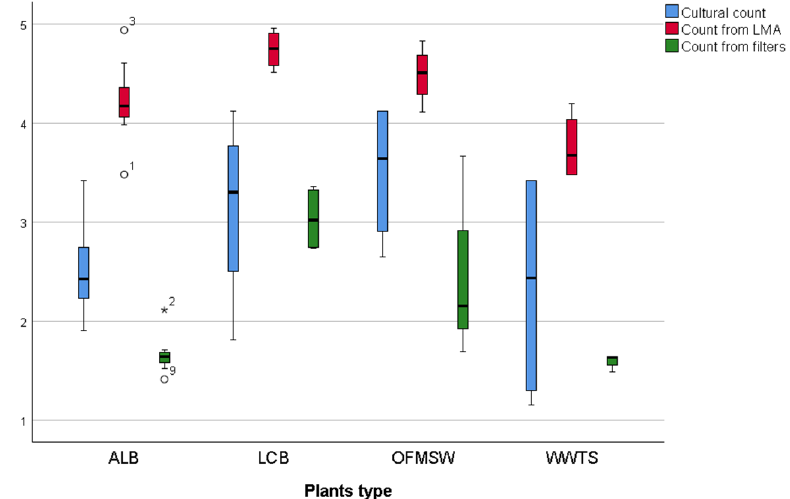
Figure 1. Boxplot of bacterial quantification methods for each plant type. Legend: cultural count represents the total mesophilic cultural count (37 °C, UFC/m 3 ), count from LMA represents the biomolecular quantification with DNA extracted from LMA plates (copies/m 3 ) and count from filters represents the biomolecular quantification with DNA extracted from filter (copies/m 3 ).